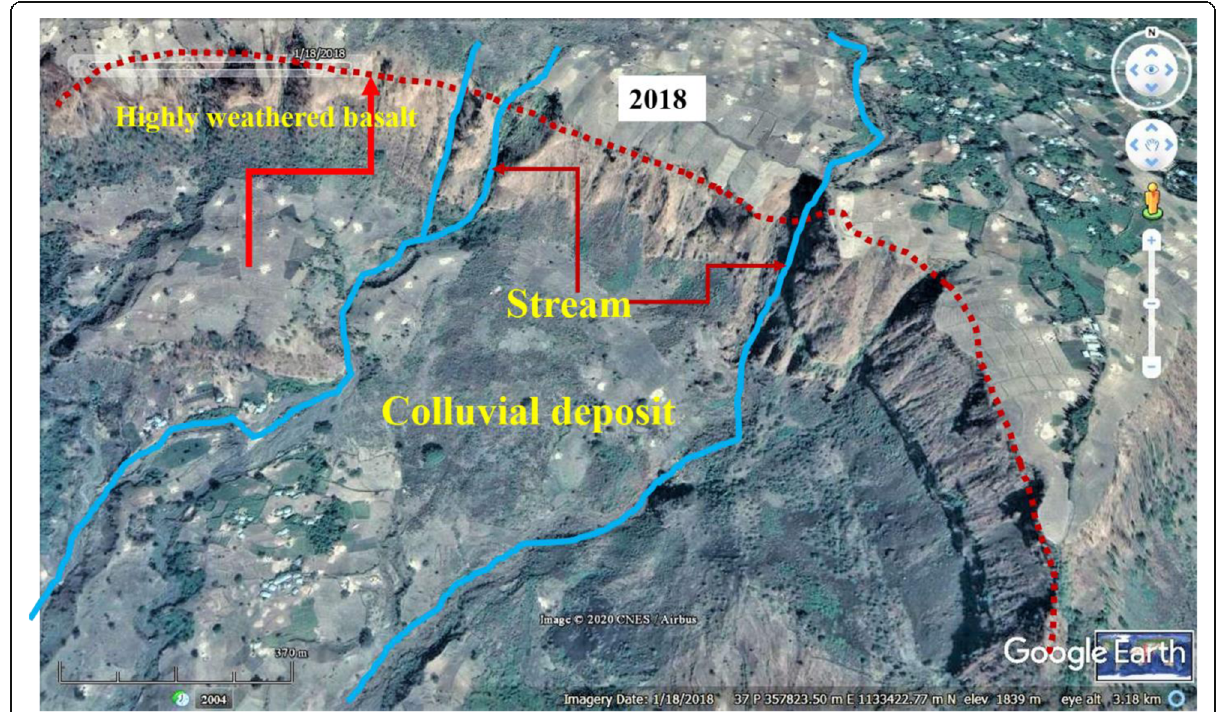
Fig. 8 Time series Google Earth Image show unfailed slope at Desa Enese village in